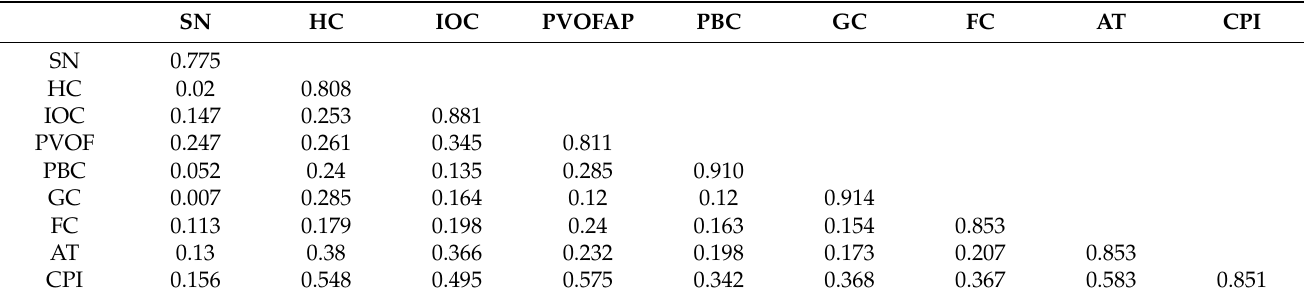
Table 4. Correlation matrix for discriminant validity.